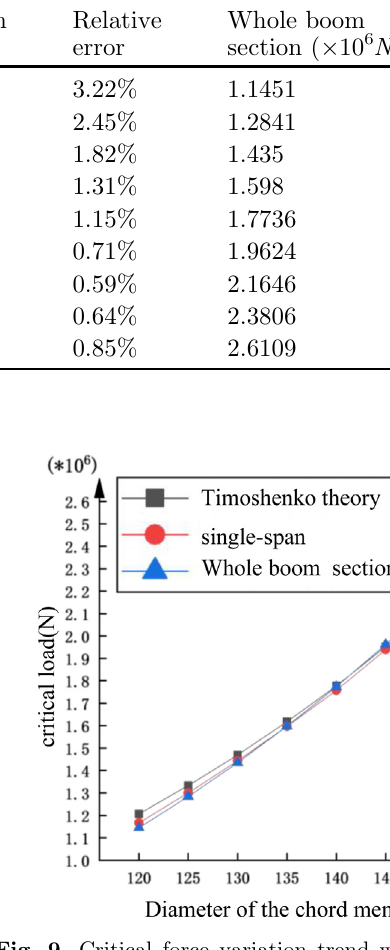
Fig. 9. Critical force variation trend with the chord member diameter